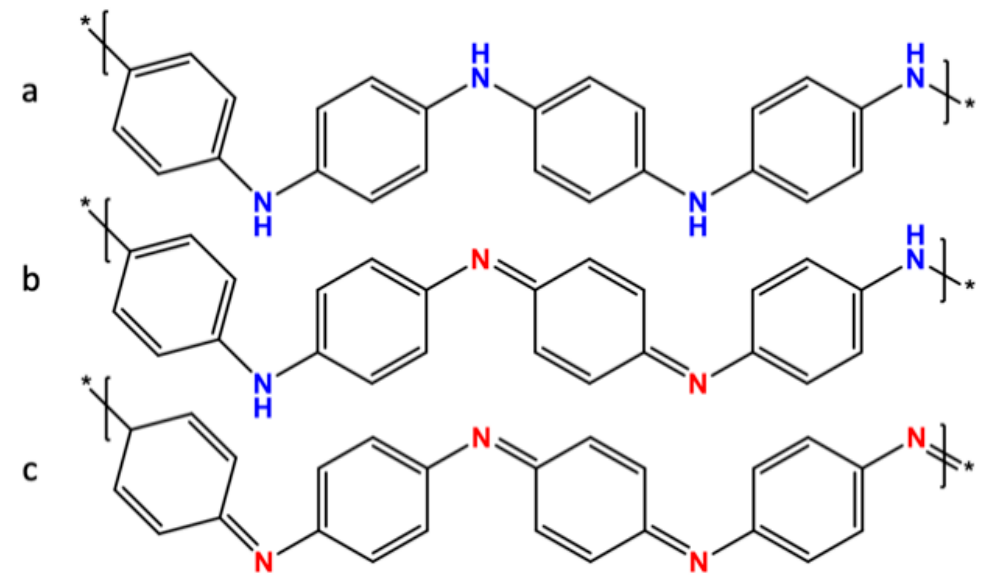
Figure 1. Atomic model of the various forms of Polyaniline (PAni), leucoemeraldine ( a ), emeraldine ( b ), and (per)nigraniline ( c ). The two types of nitrogen are amine in blue and imine in red; the ratio of these two forms dictate the kind of PAni.